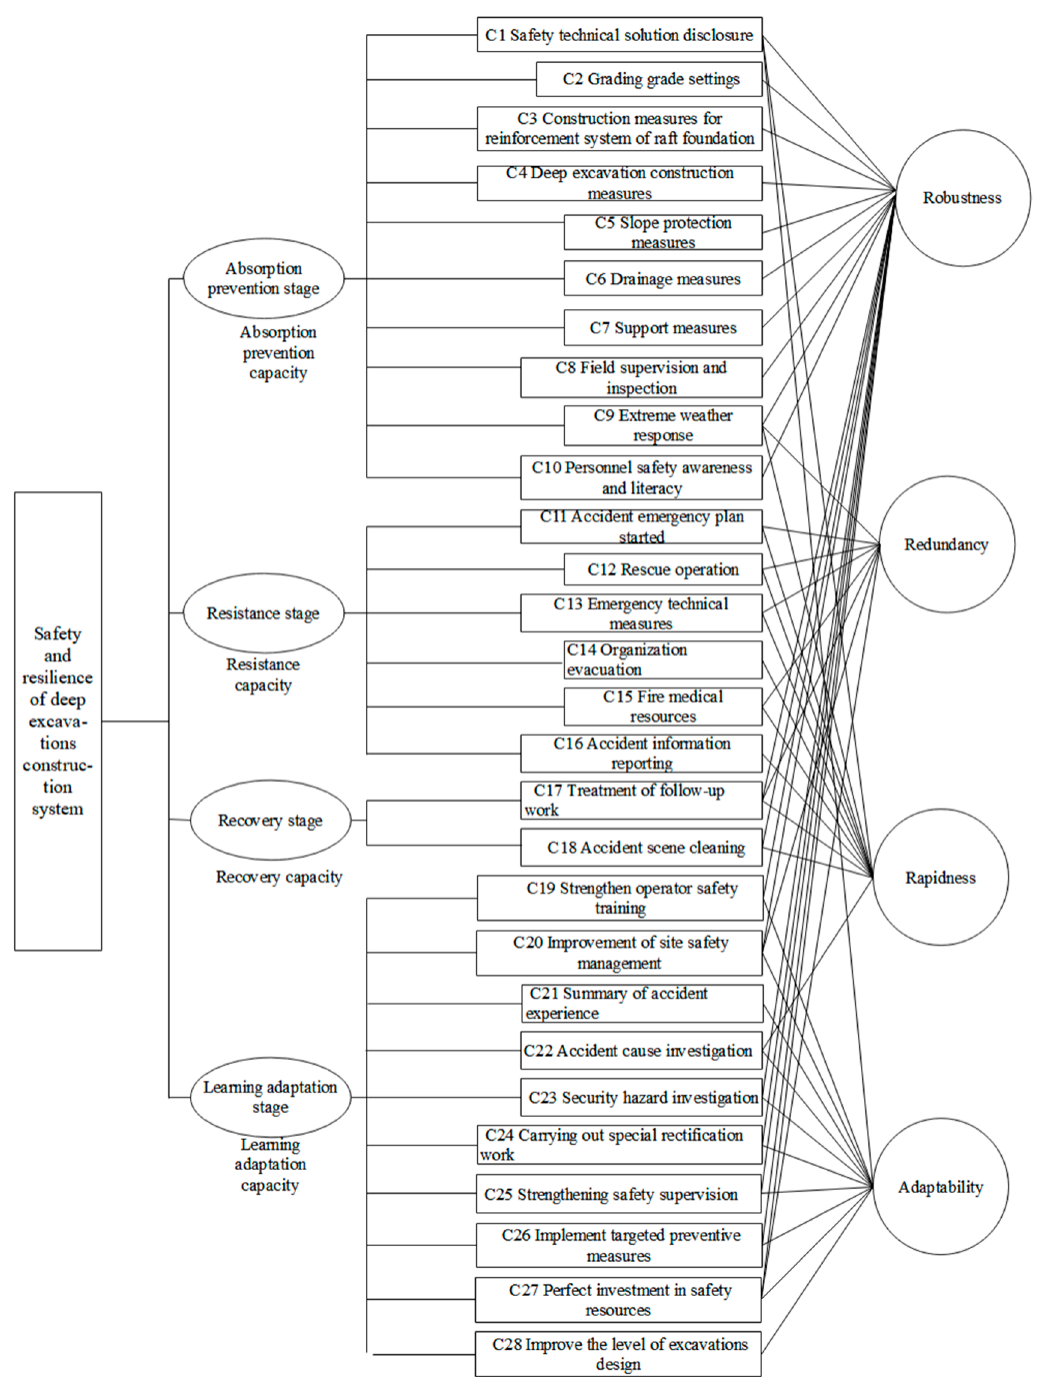
Figure 3. Impact factors of resilience based on accident process analysis.